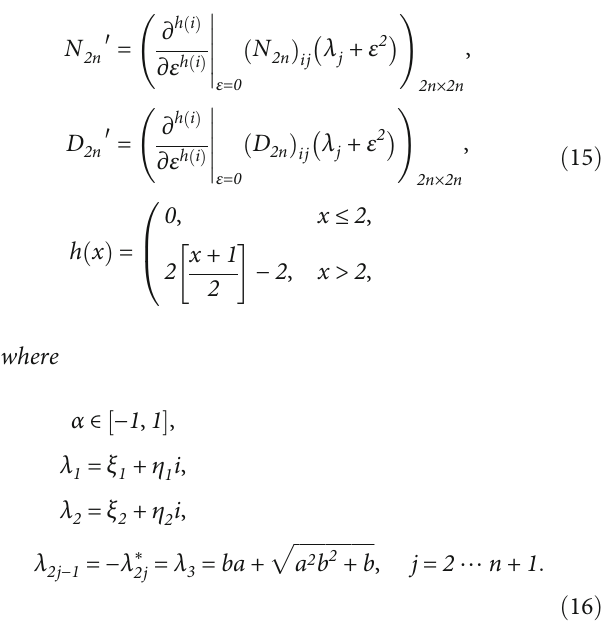
Figure 3: (a) A fi rst-order rogue wave sitting on periodic line waves described by Proposition 4 with parameters n = 1 , a = i /2 , λ ffiffiffi p 3 /2 . (b) A nonlinear superposition between a fi rst-order rogue wave and a periodic kink wave described by Proposition 4 and λ 3 = 3/2 + with parameter selections n = 1 , a = i /2 , λ 1 = 1 − 3 i , λ 2 = 3 i , and λ 3 = 3/2 +